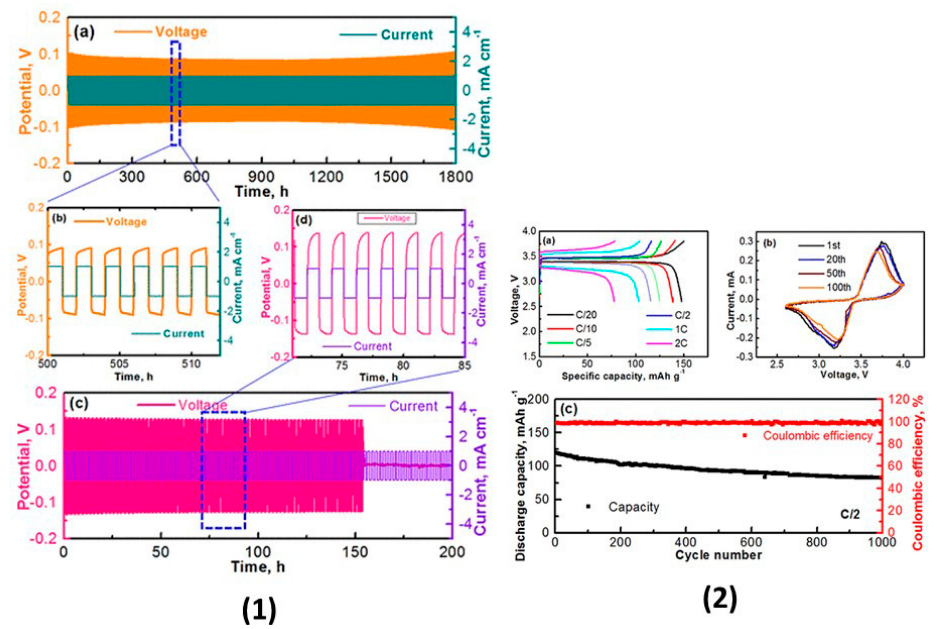
Figure 32. ( 1 ) Current and voltage profiles of the symmetric Li|PEO-LiCF 3 SO 3 -LATP|Li cell at a current density of ±1.0 mA cm − 2 and 60 °C( a ). Here PEO and LATP denote polyethylene oxide and Li 1.5 Al 0.5 Ti 1.5 P 3 O 12 , respectively. ( b ) Magnified profile of marked region of the current and voltage plots in ( a ). ( c ) Current and voltage plots of the symmetric Li|PEO-LiCF 3 SO 3 -LATP|Li cell at 60 °C. The applied current density was ±1.0 mA cm − 2 . ( d ) Magnified profile of the marked region of the current and voltage profiles in ( c ). ( 2 ) Rate capability of the Li|PEO-LiCF 3 SO 3 -LATP|LFP cell: ( a ) Charge − discharge profiles at various cycling rates at 60 °C, ( b ) cyclic voltammetry curves at different cycles, and ( c ) long-term electrochemical performances of the cell; Coulombic efficiency and discharge capacity vs. cycle number. The cell was operated at a rate of C/2 and 60 °C. Reproduced with permission from [393]. Copyright 2020 American Chemical Society.